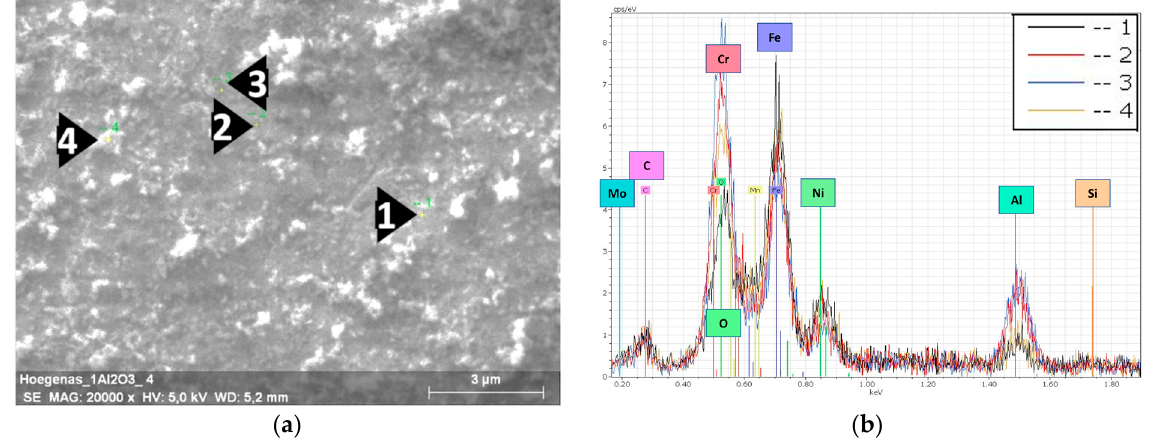
Figure 4. EDS results of the milled 316L/1 wt% Al 2 O 3 . ( a ) SEM image of a 316L grain’s surface; ( b ) EDS spectra of the selected spots.